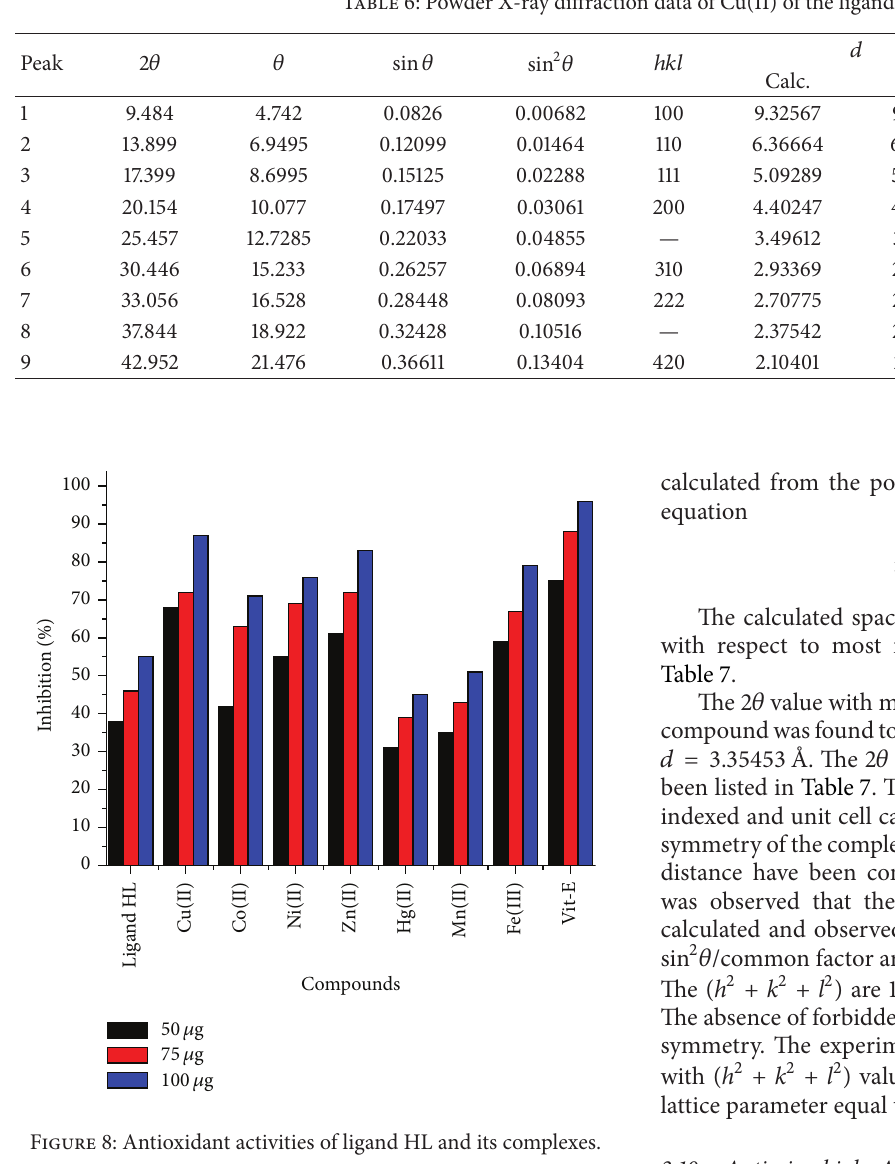
Figure 8: Antioxidant activities of ligand HL and its complexes.